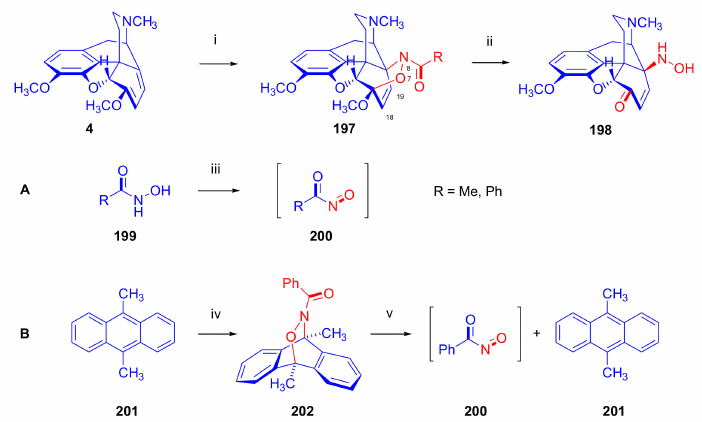
Figure 53. Hetero Diels–Alder reaction of thebaine with nitrosocarbonyl compounds. A . Formation of the nitroso reactive species. B . Diels–Alder reaction of 9,10-DMA with PhCONO and thermo retro-Diels–Alder reaction of the formed adduct. Reagents and conditions : (i): RCONHOH, Et 4 NIO 4 , aqueous AcOH-NaOAc (pH ca. 6), 0 ◦ C; (ii): HCl, MeOH, H 2 O; (iii): 1.45 equiv. Et 4 NIO 4 ,